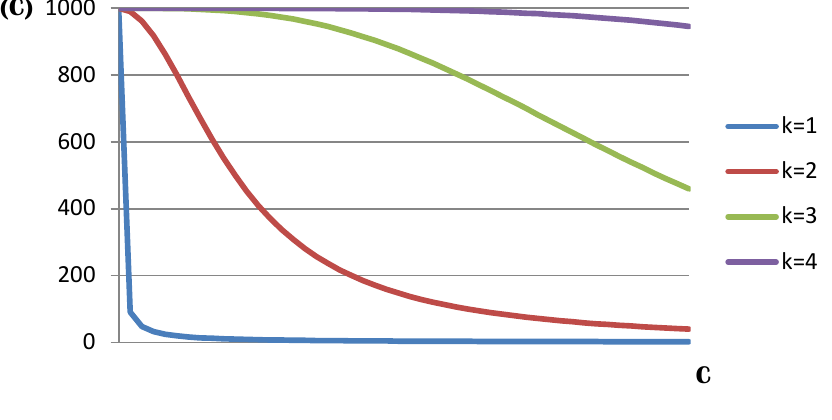
Fig. 1. Family of curves (5) for case 𝑄 = 1000, 𝑏 =0,